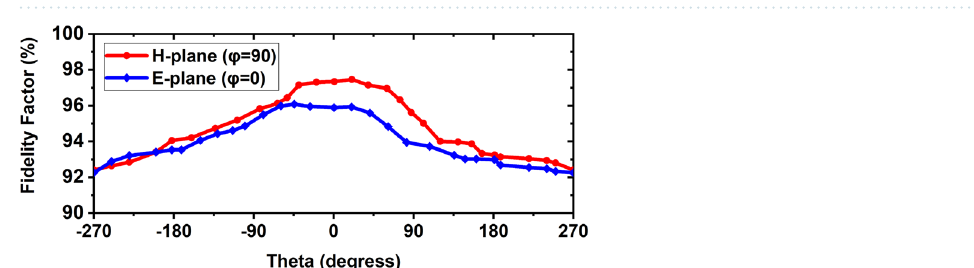
Figure 13. Near field measurements in time domain at different angles: ( a ) Received E-filed radiated pulse in E-plane; ( b ) Received E-filed radiated pulse in H-plane.